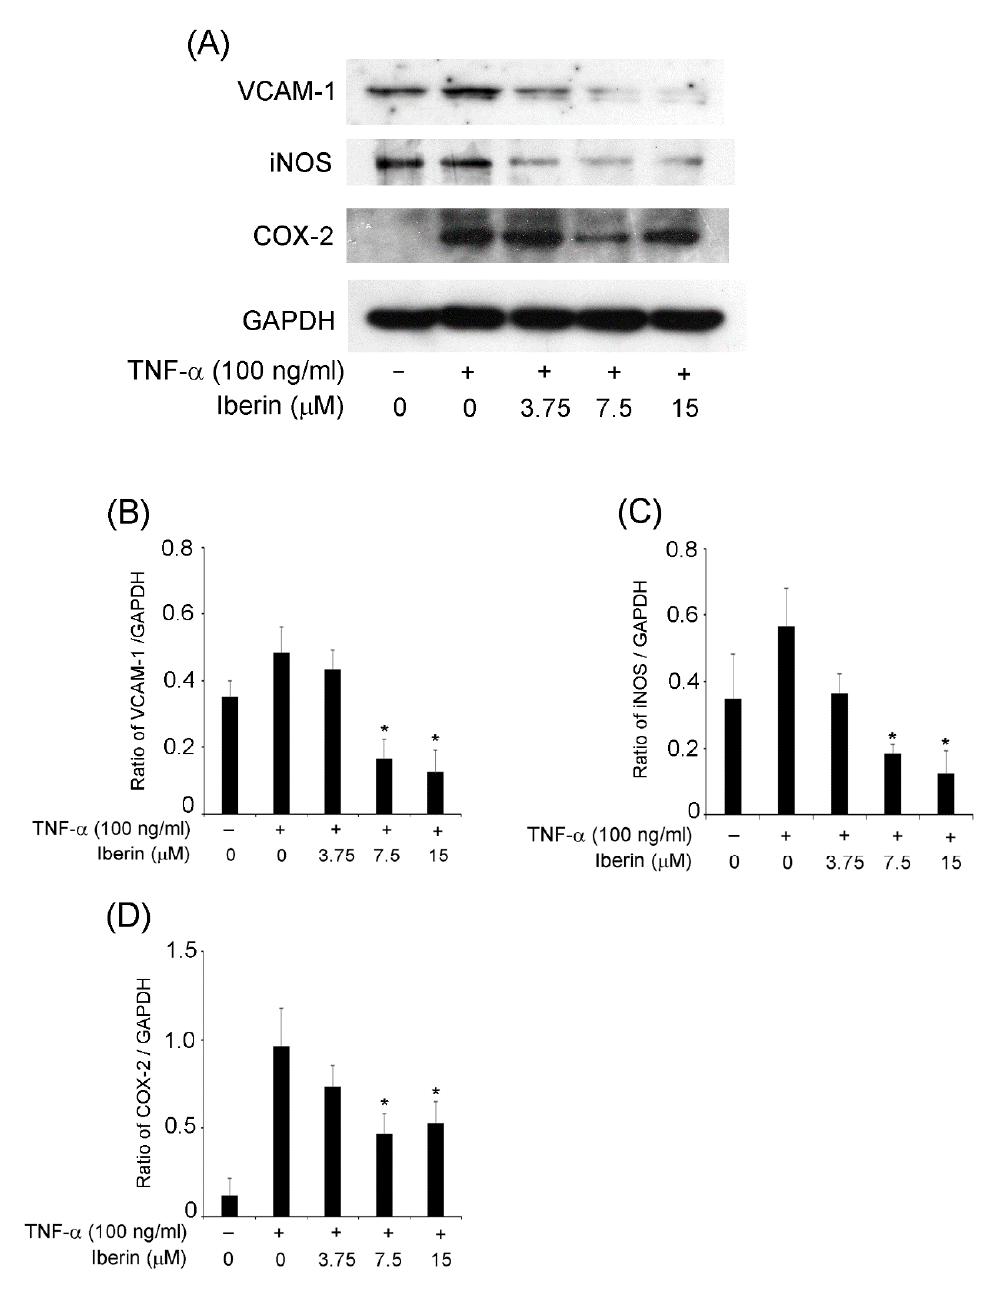
Figure 3. Effects of iberin on VCAM ‐ 1, iNOS, and COX ‐ 2 expression in TNF ‐α‐ stimulated TR146 cells. TR146 cells were pretreated for 1 h with iberin (3.75, 7.5, or 15 μ M) before being stimulated with TNF ‐α (100 ng/mL). After 24 h of stimulation, the lysates were collected. Western blot analysis was used to investigate at the expression of VCAM ‐ 1, iNOS, and COX ‐ 2. ( A ) Representative Western blot image of the expression of VCAM ‐ 1, iNOS, COX ‐ 2, and GAPDH. ( B – D ) Quantification of pro ‐ tein expression by densitometry analysis of Western blots. Data are expressed as the mean ± SD of thre independent experiments. (* = p < 0.05 vs. TNF ‐α‐ stimulated TR146 cells without iberin).